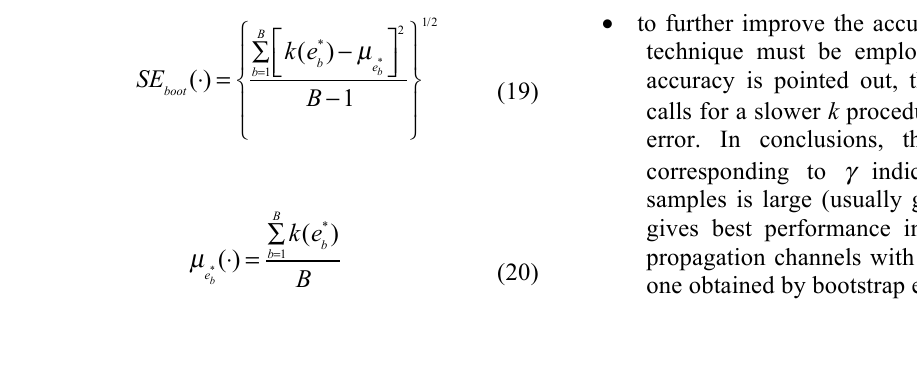
After the resampling with replacement to each bootstrap samples is in place, bootstrap replications k ( e